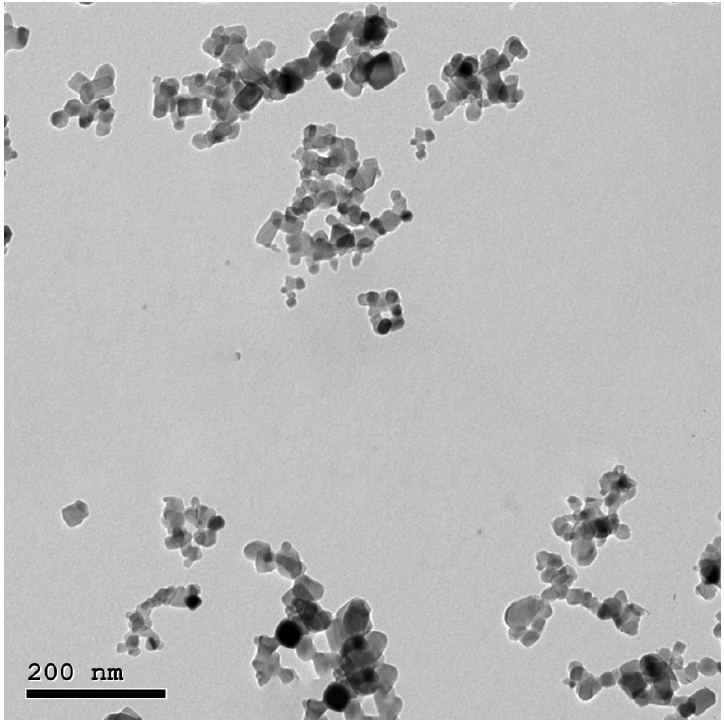
Figure 1. TEM image of ZnO-NPs illustrates the spherical and sub-spherical shapes with clear edges without any agglomeration.